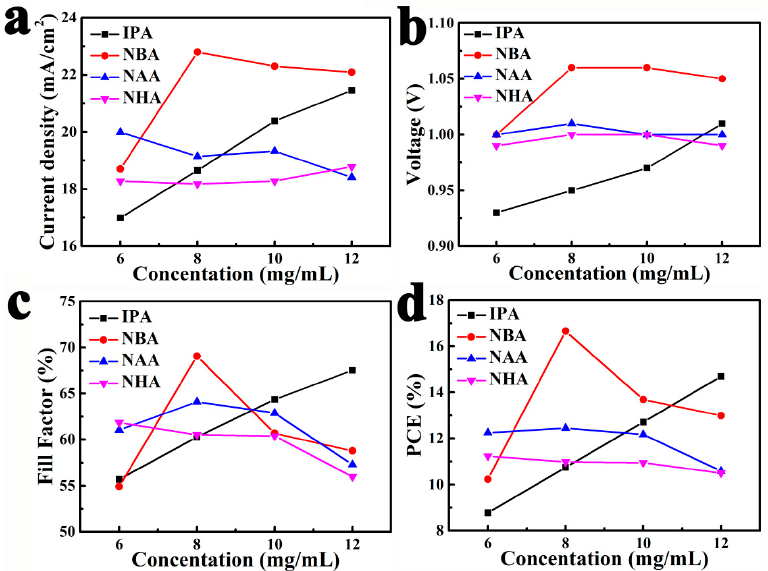
Figure 2. Detail parameters and power conversion efficiencies (PCEs) of the cells prepared by using MAPbI 3 films obtained from 6–12 mg/mL MAI in IPA, NBA, NAA, or NHA.